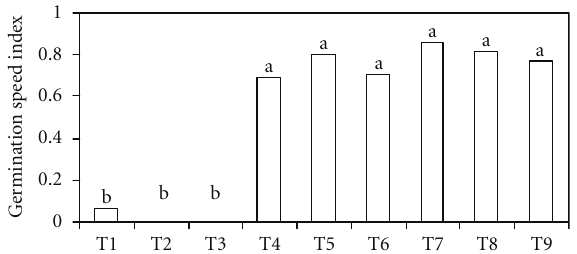
Figure 2: Germination velocity index of Ormosia arborea seeds sub- mitted to di ff erent dormancy breaking treatments. T 1 : control; T 2 : immersion in 100 ◦ C water; T 3 : immersion in boiling water followed by 24h of soaking; T 4 and T 5 : scarification with number 100 and number 50 sandpaper, respectively; T 6 , T 7 , T 8 , and T 9 : immersion in sulfuric acid for 1 hour, 50min, 45min, and 30min,